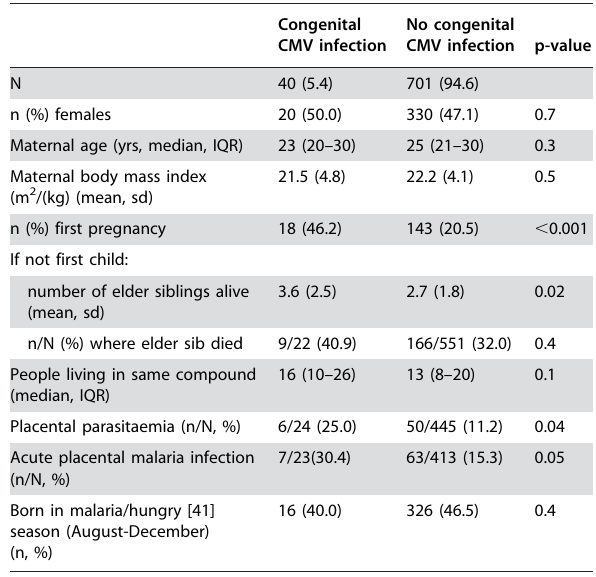
Table 1. Background characteristics of babies born with and without congenital CMV infection recruited January 2002 to